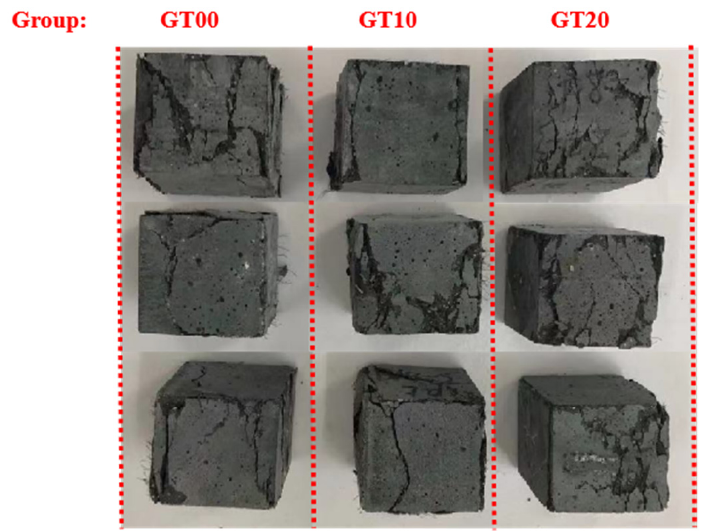
Figure 7. Specimens after compression damage.